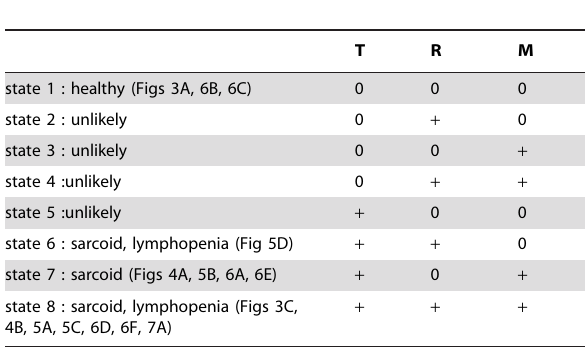
Table 1. Long-term states predicted by the qNET shown in Figure